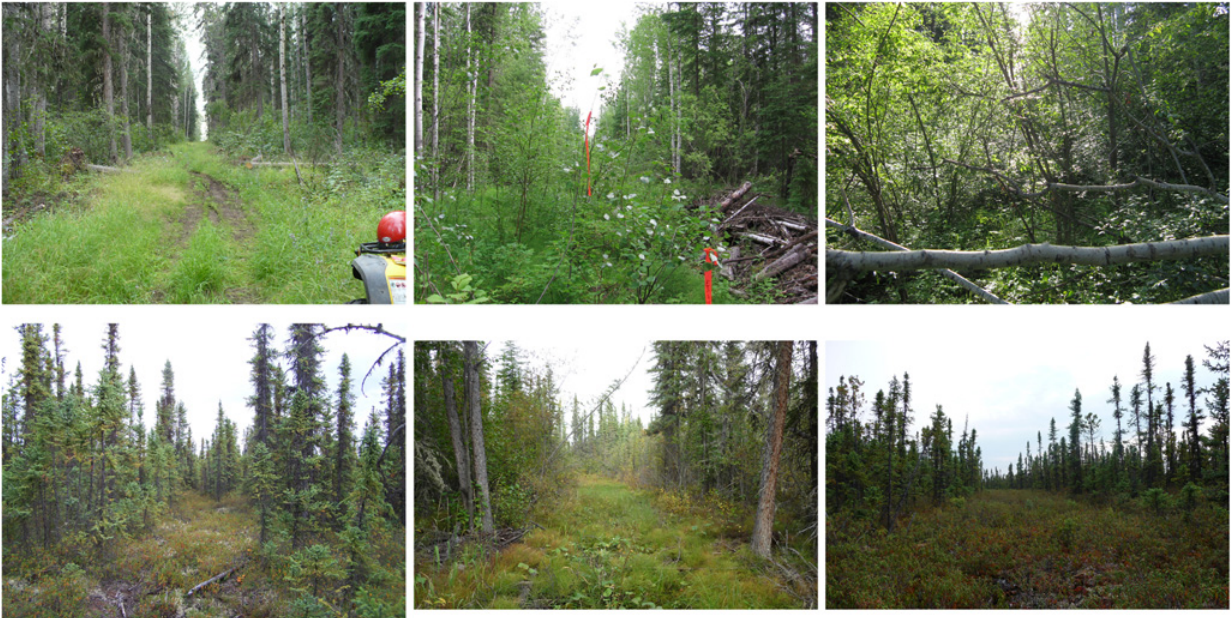
Fig 2. Examples of sampled seismic line types. In the field we identified and sampled along the following 6 types of seismic lines: (Top row, from upper left) 1) (cid:1) 6 m wide and open (open conventional); 2) (cid:1) 6 m wide and partially recovered (partial conventional); 3) (cid:1) 6 m and recovered (closed conventional); (Bottom row, from left) 4) open and (cid:3) 2 m wide (open 2 m); 5) open and 3 – 4 m wide (open 3 – 4 m); 6) open and 5 m wide (open 5 m). Photo credits: J.